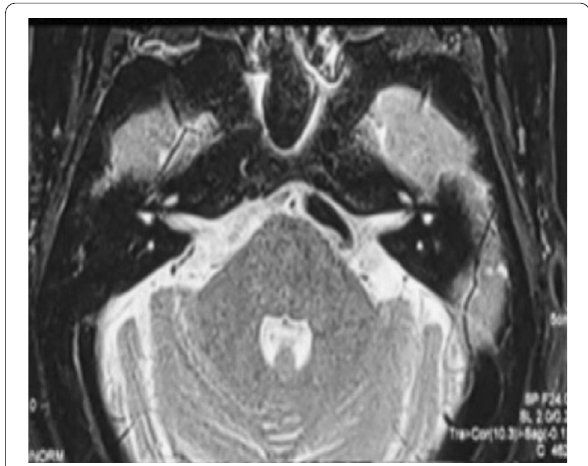
Fig. 1 Axial T2 weighted image MRI brain of one of the patients showing left sided neurovascular compromise (found to be